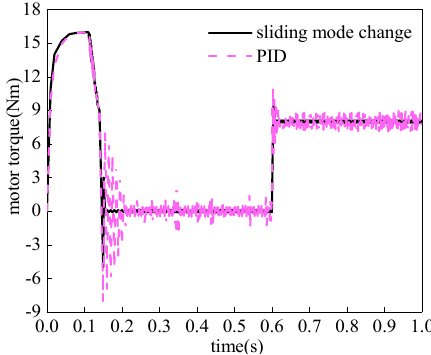
Figure 6. Motor torque simulation.